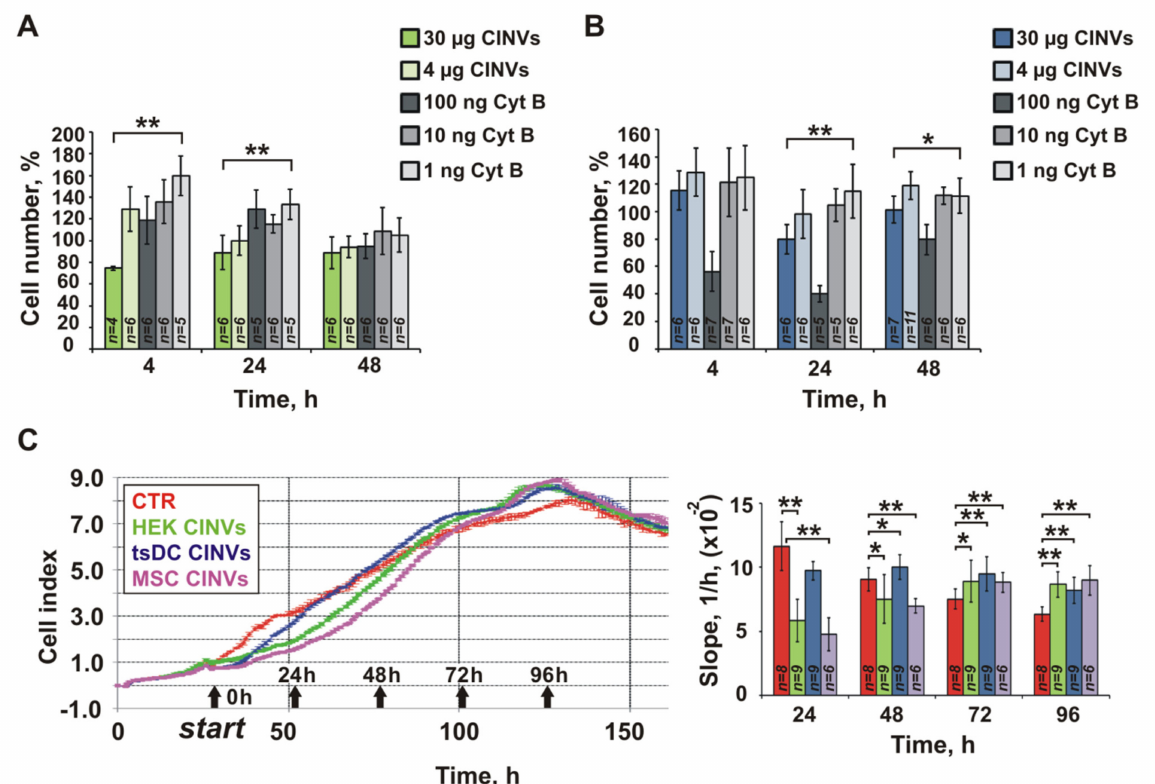
Figure 6. Effect of CINVs on proliferation of A549 ( A , C ) and L929 ( B ) cells. ( A – B ). WST-1 assay. Cells were incubated with 4 or 30 µ g empty CINVs per well or with 1, 10, or 100 ng free Cyt B. Cell proliferation was analyzed after 4 h, 24 h, or 48 h of treatment. The absorbance measured in control (intact) cells was set at 100%. ( C ). Data of real-time impedance-based assay (xCELLigence). Progress curves of A549 proliferation in the presence of 30 µ g CINVs of various cellular origins. Cells treated with HEK CINVs—green, tsDC CINVs—blue, MSC CINVs—purple, control cells (CTR)—red. Results were expressed as cell index representative graphs and the rate of cell index change (slope). The number of measurements is indicated as n . Data are presented as the mean ± SD. Statistical analysis was performed using the Mann–Whitney U test; * p ≤ 0.05, ** p ≤